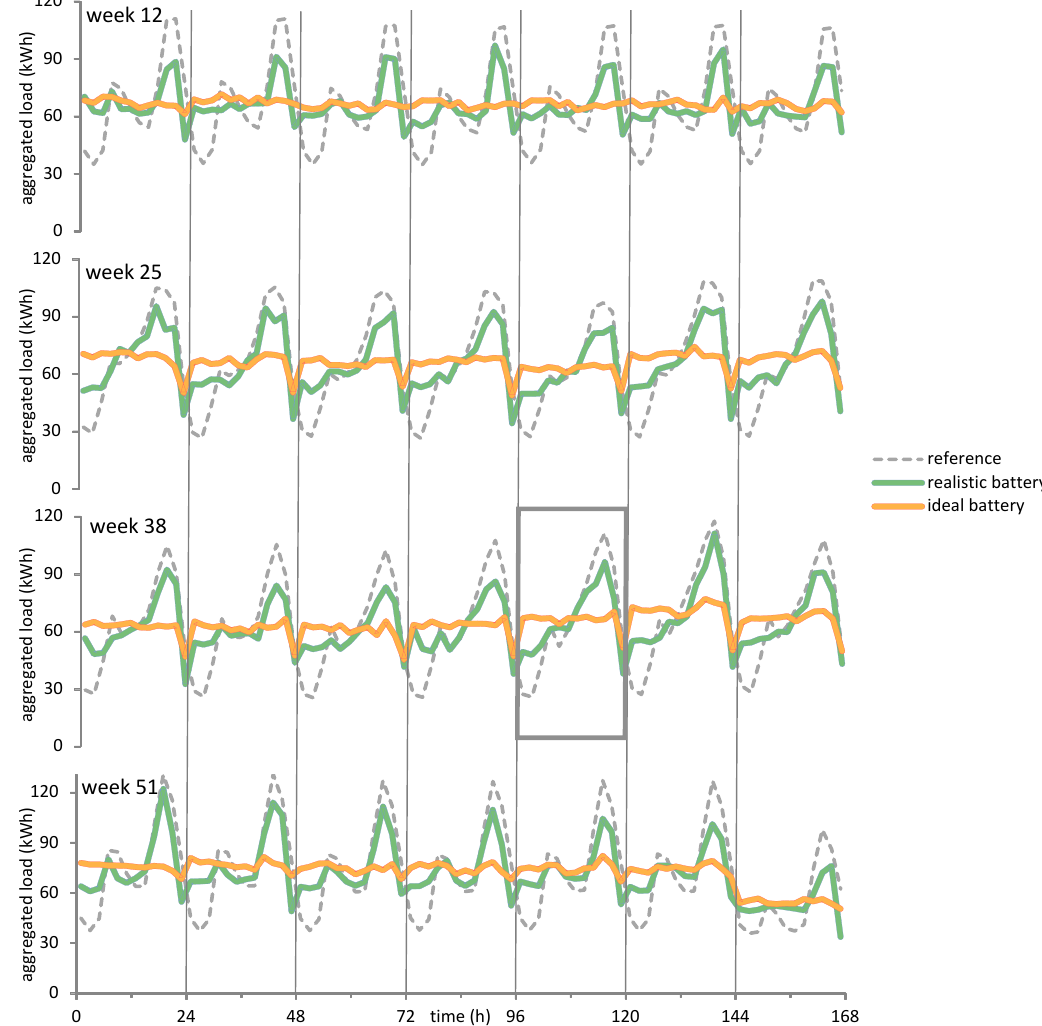
Figure 2. Aggregated load curves over four different one-week periods; i.e., week 12, week 25, week 38, week 51 in the data set [20]. For each week, the results for not playing the game (reference) can be compared to the results obtained from playing the game with either a realistic battery or an ideal battery model. For week 38, day 5 is highlighted in reference to the results shown in Figure 3. Table 2. Peak-to-average ratios calculated as the average over the individual days of week 12, week 25, week 38, and week 51 for the case without storage system (Reference) and both battery models. µ gives the average over all four weeks. IB: “ideal” battery; RB: “realistic” battery. Reference RB Model IB